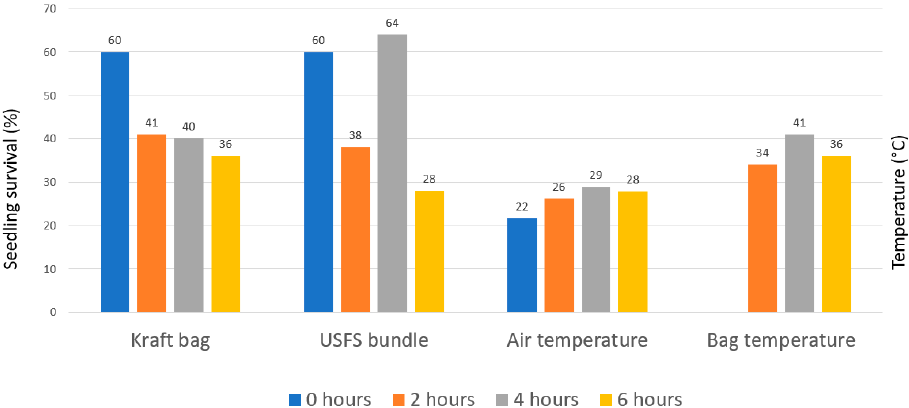
Figure 28. Survival of loblolly pine seedlings lifted on 13 March, stored in a cooler for 47 days at 3.3 °C in either kraft-polyethylene bags or bundles, and planted on 29 April, 1970. Data from [177]. Each package contained 1000 bareroot seedlings, and seedlings were extracted and planted from packages at 9:30 a.m. (zero exposure), 11:30 a.m. (2 h), 1:30 p.m. (4 h) and 3:30 p.m. (6 h of exposure while in the bag or bundle). The interaction between the packing method and the exposure time was not significant ( α = 0.05). The least significant difference ( α = 0.05) for a one-tail test is − 17% and ± 32% for a two-tailed